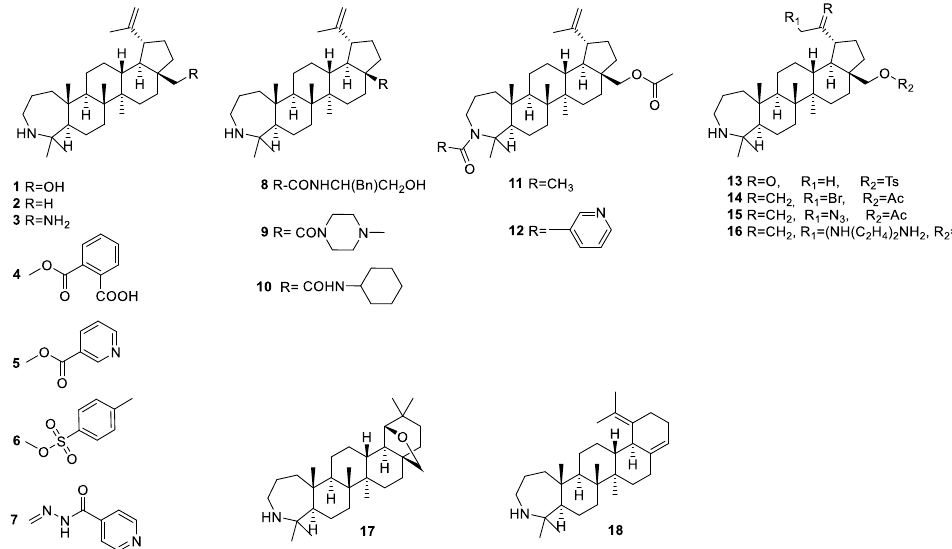
Figure 1. The structures of previously synthesized [26,29 – 35] lupane-type azepano-triterpenoids.